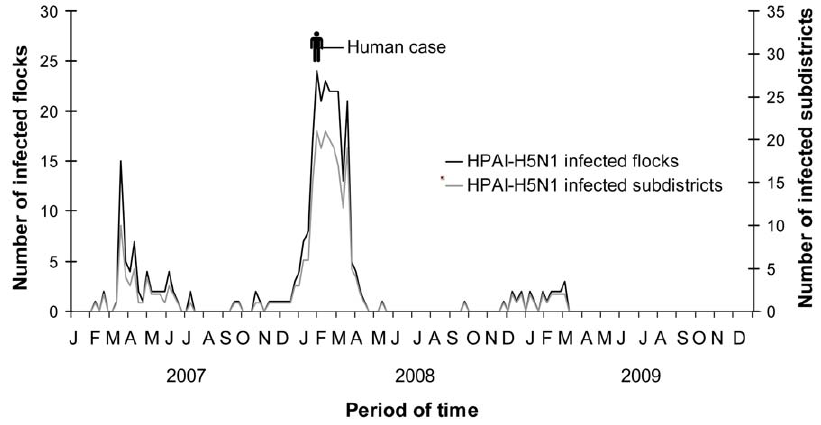
Figure 1. Weekly number of HPAI-H5N1 infected flocks and subdistricts, Bangladesh, 2007–2009.